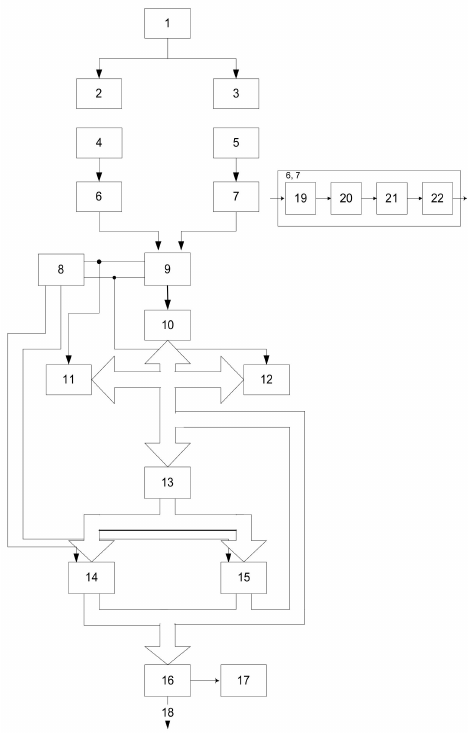
Figure 8. Block diagram of a device for diagnosing vascular disorders. The output of the source 1 of the pulse voltage is connected to the inputs of the first 2 and second 3 sources of IR radiation, the optical outputs of which are connected respectively to the optical inputs of the first 4 and second 5 IR receivers, the outputs of which are connected to the inputs of the first 6 and the second 7 analog signal processing units, the outputs of which are connected to the input of the analog multiplexer 9, the address inputs of which are connected to the first and second inputs of the control device 8, and the output to the ADC input 10, the output bus of which is connected to the inputs of the first 11 and a second 12 display units, the control inputs of which are connected to the corresponding address inputs of the multiplexer 9 and to the input of the register 13, the output bus of which is connected to the inputs of the first 14, second 15 RAM, the control inputs of which are connected to the outputs, the output buses of the RAM are connected to each other and connected to the input of the register 13 and the MP 16, the output of which is connected to the output of the device 18 and the display